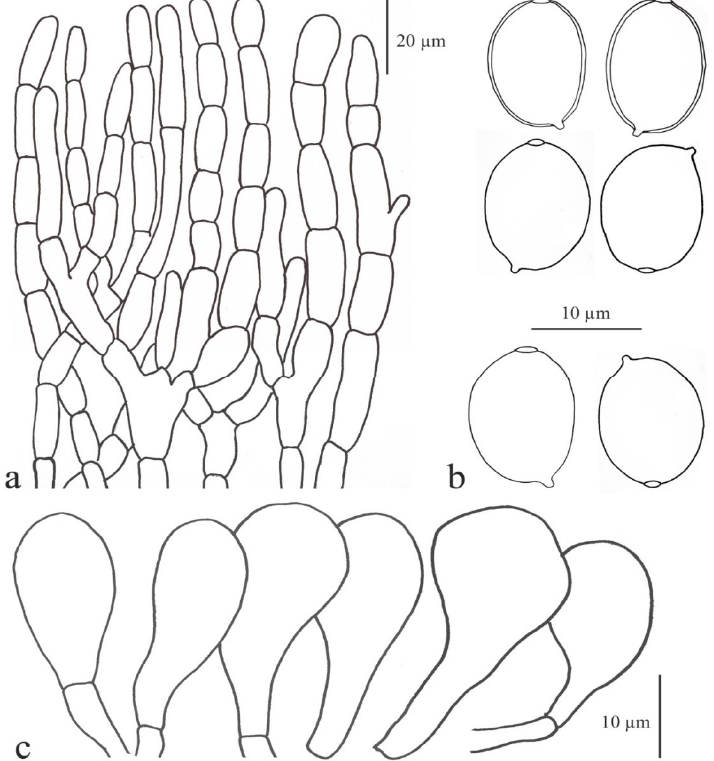
Figure 18. Microcharacters of Macrolepiota dolichaula (MFLU 12-1816). ( a ) pileus covering. ( b ) basidiospores. ( c ) cheilocystidia. Pileus 75–175 mm, first subglobose to globose, soon expanding to campanulate, um- bonate with high umbo, with inflexed margin, with brownish-orange to light-brown (6C5–6, 6D6–7) glabrous surface and smooth when young, soon surface radially broken